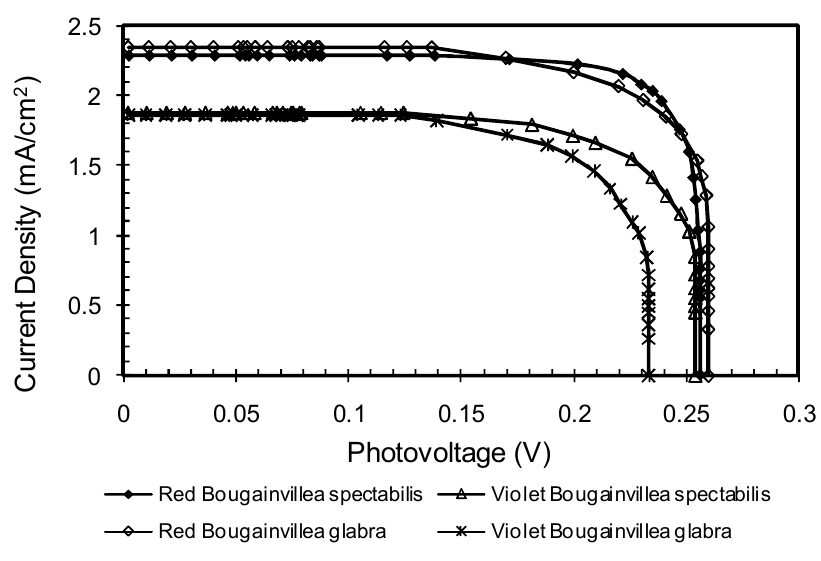
Figure 7. Power-photovoltage curves for a Bougainvillea extract sensitized solar